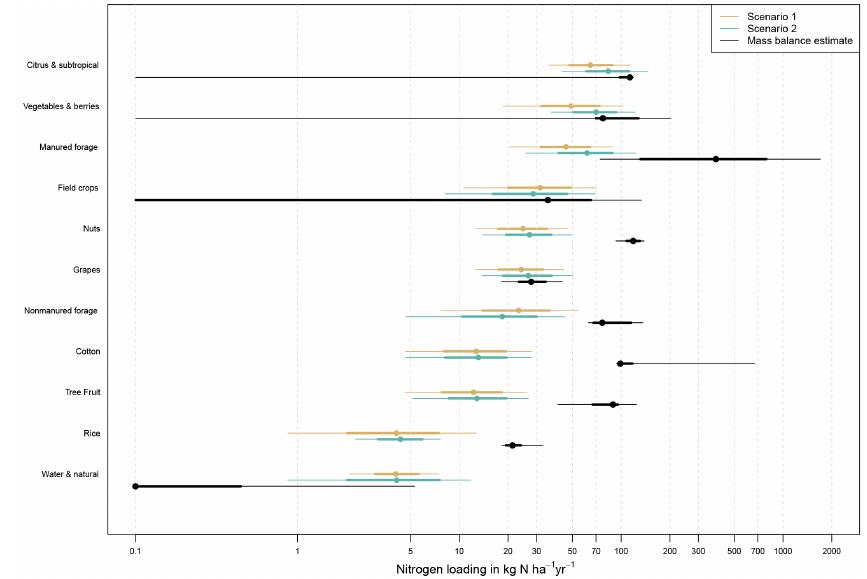
Figure 8. Credibility intervals of posterior probability densities of estimated nitrogen loading rates for selected crop groups plotted with the 1990 loading rates (black) estimated using a mass balance approach with the Groundwater Nitrogen Loading Model (GNLM) (Rosenstock et al., 2013; Harter et al., 2017) (black). Thinner lines are 95% credibility intervals, thicker lines are 68% credibility intervals, and the dot is the median estimated